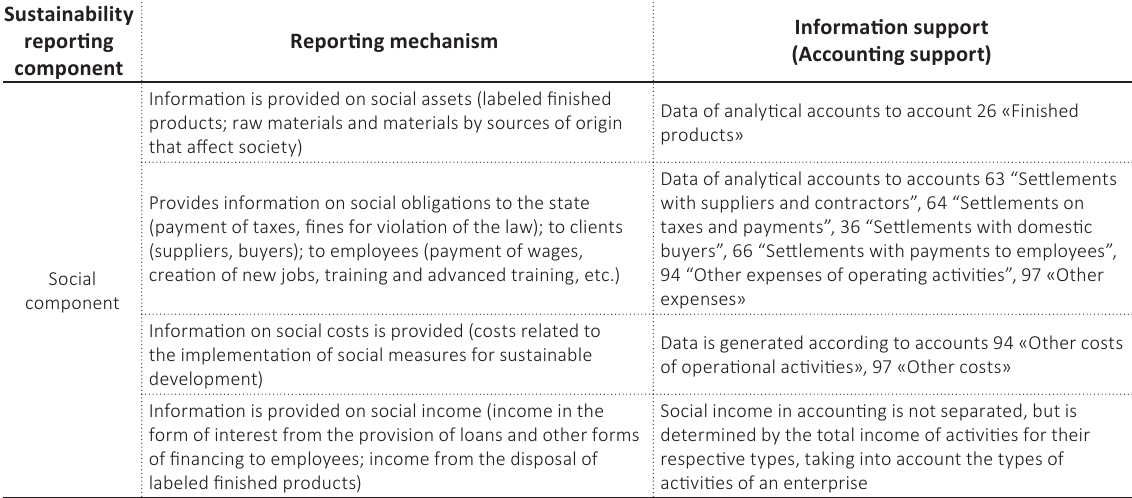
Table 2. Accounting support to generate a fragment of sustainability reporting: the social